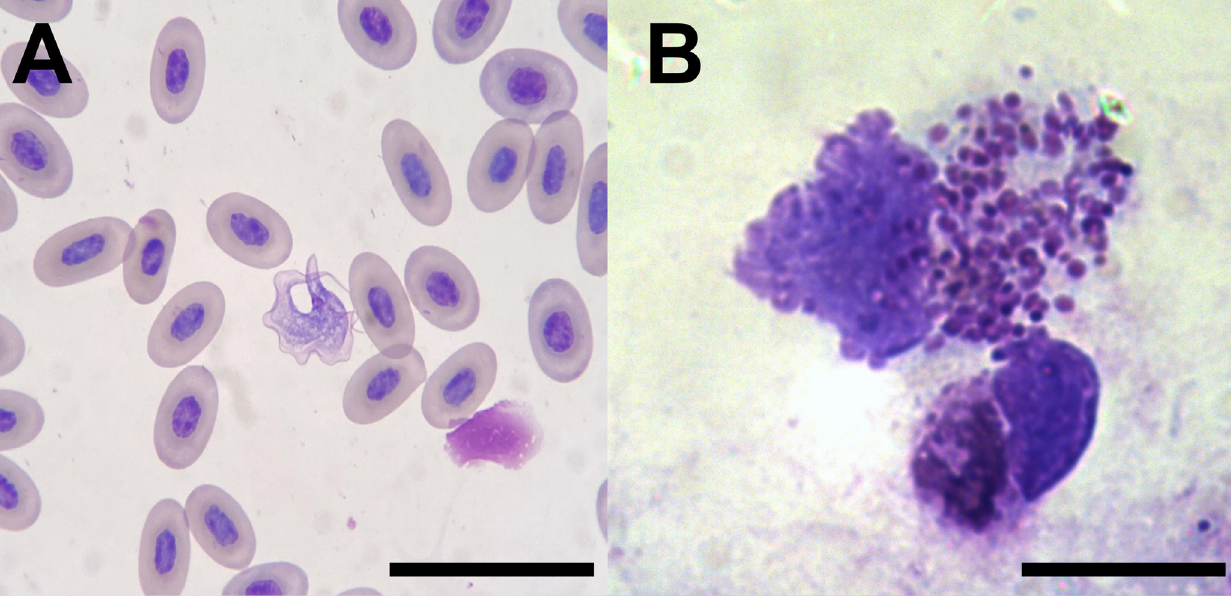
Fig 4. Trypanosomatidae from geckoes. A) Trypanosoma sp. trypomastigotes in blood of Tarentola mauritanica gecko. B) molecularly identified Leishmania infantum amastigote-like forms in leukocyte of Tarentola mauritanica gecko. Scale bars A) 50 μ m; B) 10 μ m.